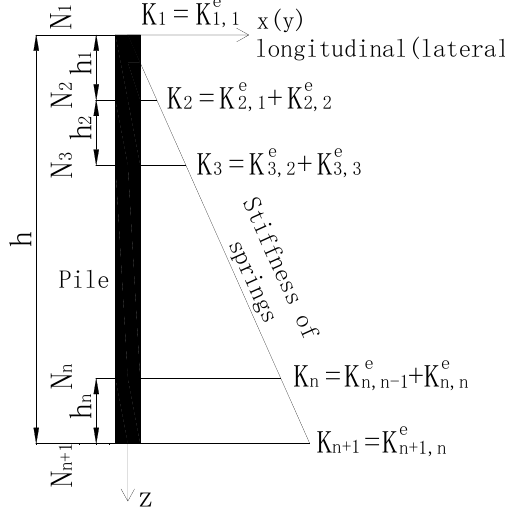
Figure 13. Schematic presentation of the equivalence.